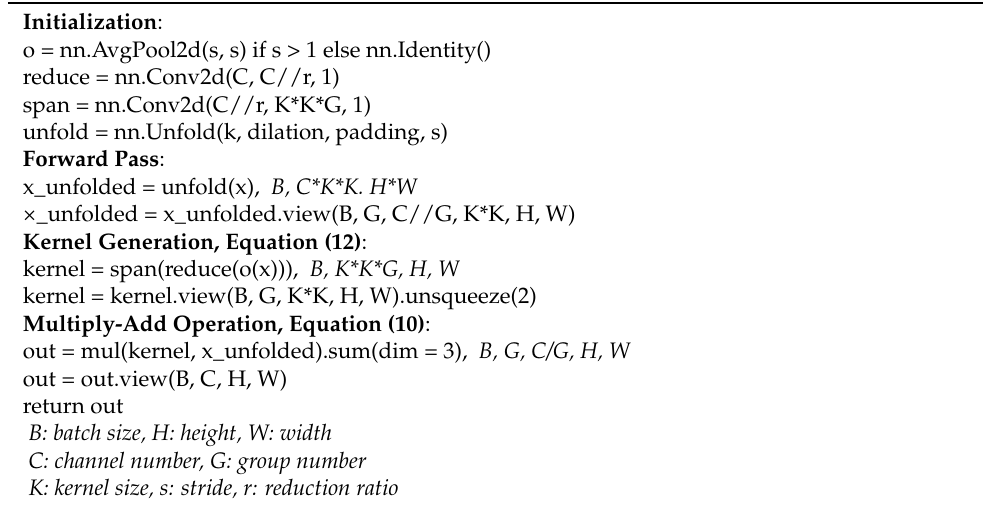
Algorithm 1 Pseudo code of involution in a PyTorch-like